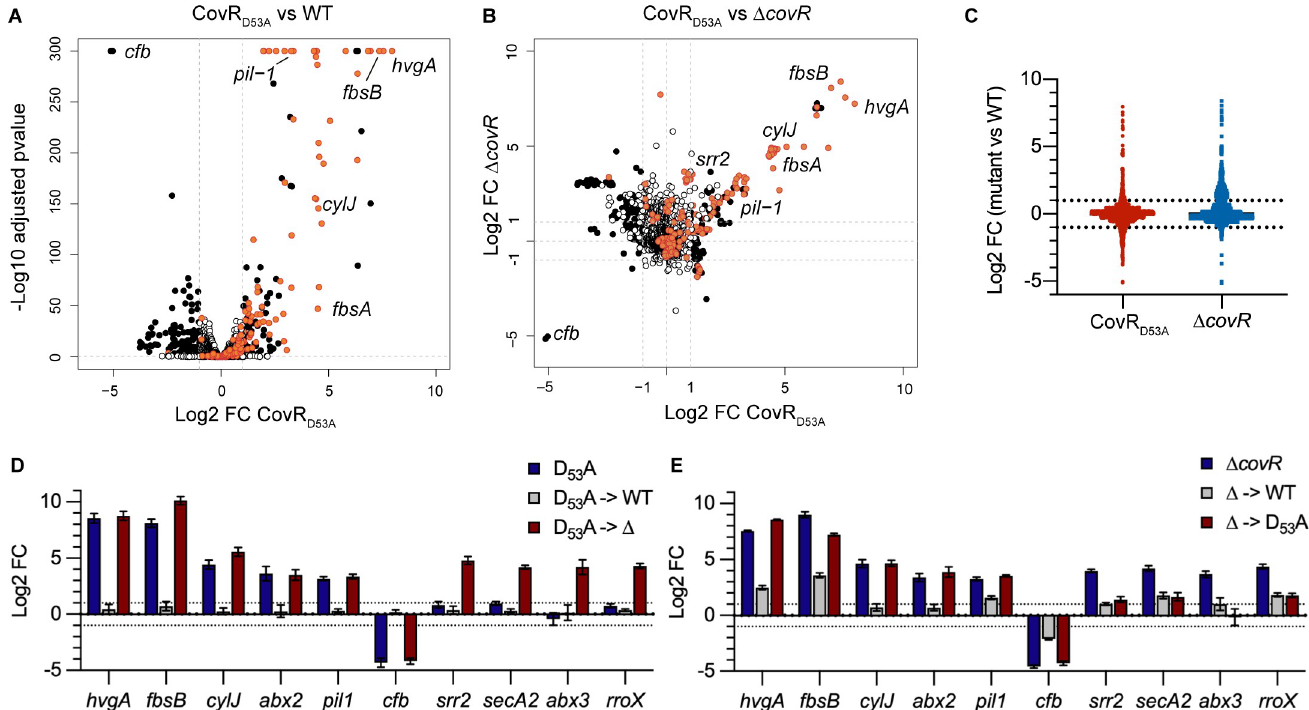
Fig 1. The CovR regulon in the hypervirulent BM110 strain. (A) Volcano plot of the BM110 CovR D53A transcriptome at mid-exponential phase in THY. Each dot represents one of the 2178 genes with its RNA-seq fold change and adjusted p-value (Wald test) calculated from three independent replicates. Black and white dots symbolized significant (|Log 2 FC| > 1; adjusted p-value < 0.005) and non-significant differentially transcribed genes, respectively. Red dots are genes associated to a CovR binding region identified by ChIP-Seq (see Fig 2), with selected gene names highlighted. (B) Pairwise comparisons of the BM110 CovR D53A and Δ covR mutant transcriptomes. Each dot has the same color-coded as in (A), corresponding to significant vs non-significant differential gene expression in the CovR D53A mutant. Dots dispersion represents mutant-specificities. (C) Dot plots of RNA-seq fold changes for all genes in the Δ covR (blue) and CovR D53A (red) mutants. Note the opposite trends in the total number of mild up-regulated genes (1 < log2 FC < 3) in the Δ covR mutant and of down-regulated genes (-3 < log2 FC < -1) in the CovR D53A mutant. (D) Validation of gene expression by qRT-PCR in the CovR D53A mutant (D 53 A), the chromosomally complemented strain (D 53 A- > WT), and in a Δ covR mutant done in the CovR D53A background (D 53 A- > Δ ). (E) Validation of gene expression by qRT-PCR in the Δ covR mutant ( Δ ), the chromosomally complemented strain ( Δ - > WT), and in a CovR D53A mutant done in the Δ covR background ( Δ - > D 53 A). Means and standard deviations of log2 fold change (mutant versus WT) are calculated from three biological replicates.